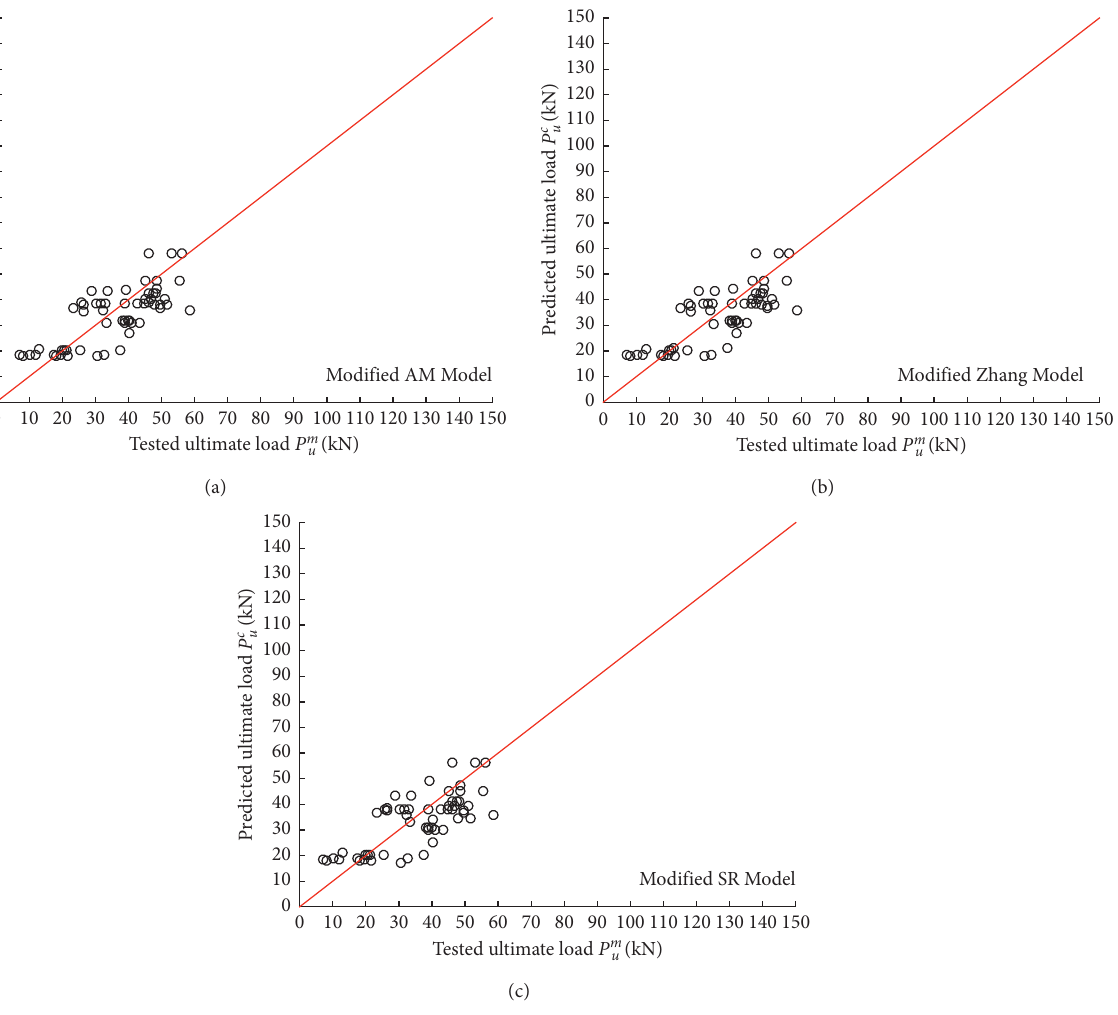
Figure 9: Comparison between the calculated value and the experimental value for the three modified models under adhesive-concrete interface failure mode: (a) AM Model, (b) Zhang Model, and (c) SR Model.